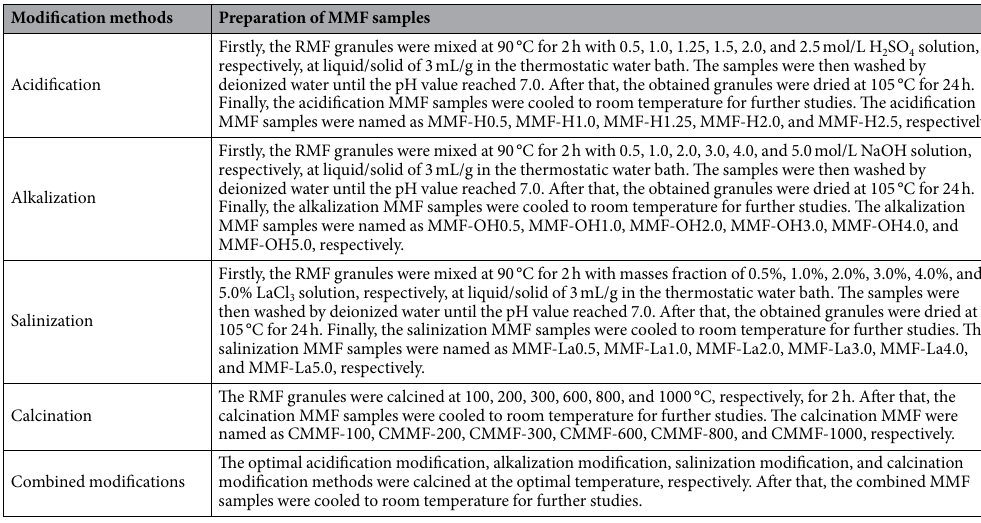
Table 5. Preparation of different MMF